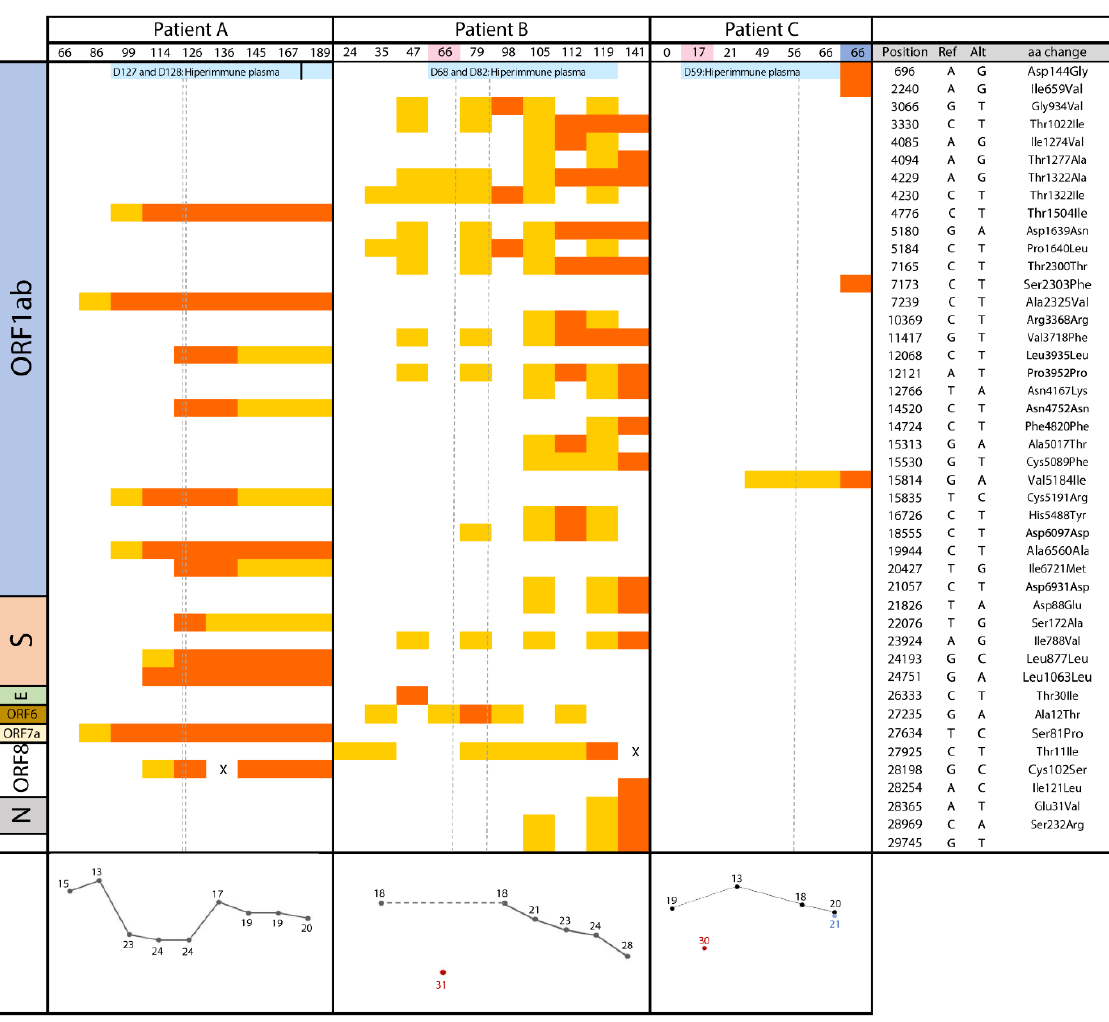
Figure 2. Chronological acquisition of diversity for the three study cases (days are indicated at the upper file; days coloured in pink correspond to plasma, in blue to bronchoaspirate, and without colour to nasopharyngeal specimens). On the left side, the SARS-CoV-2 genetic content is indicated. Single nucleotide polymorphisms are indicated in orange, when identified as fixed, and in yellow when they are found as minority/intermediate variants. In the right panel, the coordinates and specific substitutions are shown (nonsynonymous changes are highlighted in bold). At the bottom panel, Ct values for the specimens used in the sequencing analysis are shown. Dots out of the lines correspond to specimens other than nasopharyngeal (plasma and bronchoaspirate). All sequencing data covered >96% of the reference genome, with a 100X depth. The positions with an “X” correspond to the only 2 positions involved in the diversity analysis, which were not sufficiently covered in two specimens among those in the study.